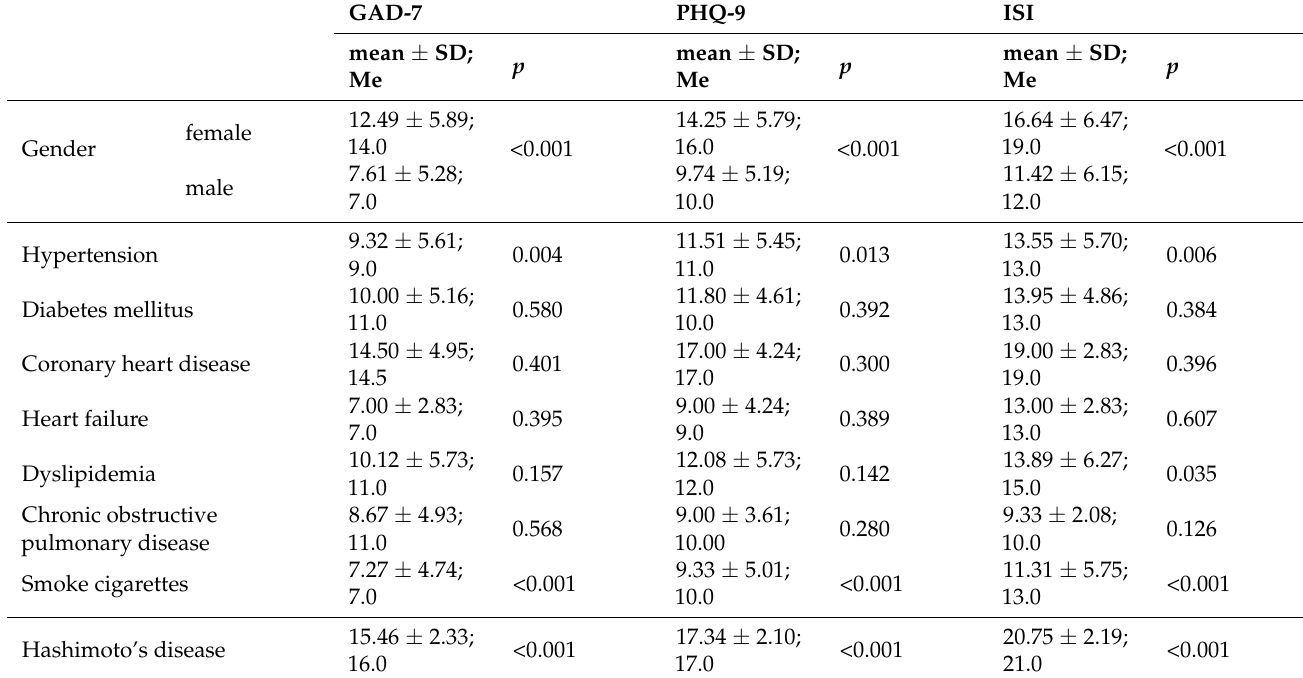
Table 1. Mean GAD-7, PHQ-9, and ISI scores for selected parameters.